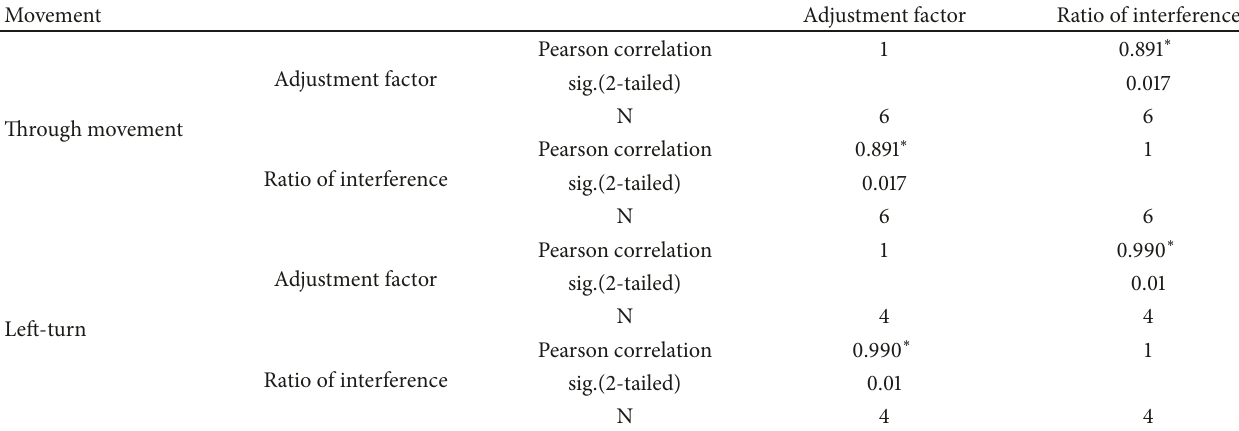
Table 10: Correlation